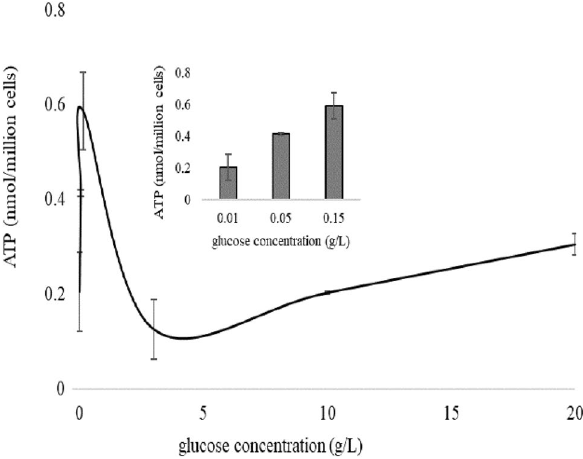
Figure 4. Adenosine triphosphate (ATP) content of yeast cells cultured in 0.01, 0.05, 0.15, 3, 10 and 20 g/L glucose for 3 h. Insert data represented ATP content of yeast cells in 0.01, 0.05, and 0.15 g/L glucose for 3 h.